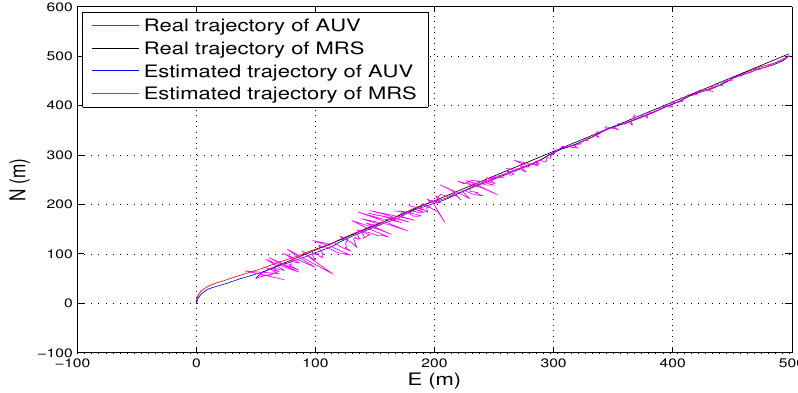
Figure 11. The real trajectory and estimated trajectory of AUV and MRS.